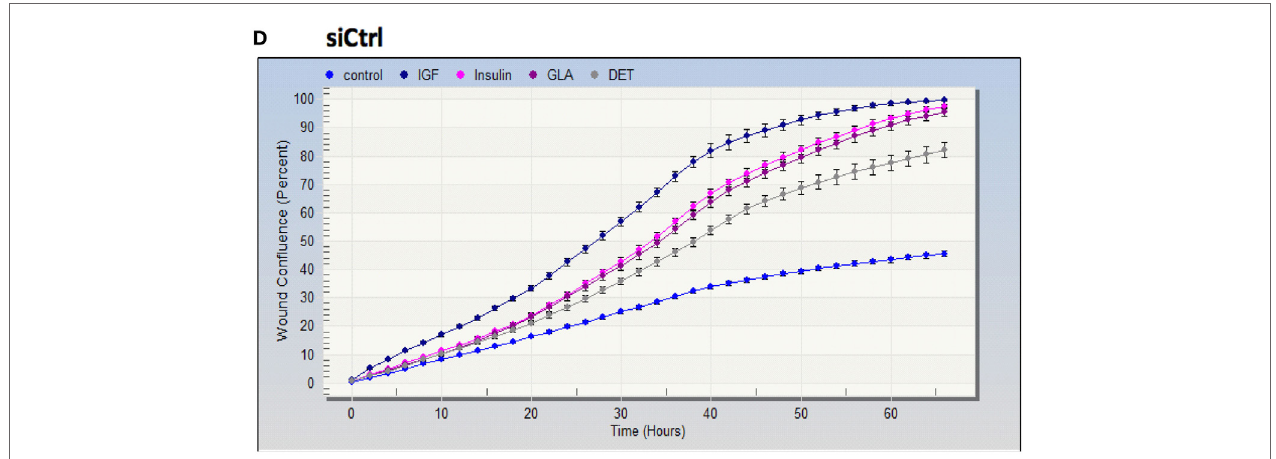
FigUre 13 | Cell migration measurement in FLNA-silenced cells. Cell migration assays were performed in ECC-1 cells transfected with 10 µM siFLNA (or siCtrl), as described in Section “Materials and Methods.” Cells were scratch wounded and monitored to determine the rate of migration into the scratched area. Representative images indicate areas of the scratch wound that are occupied by ECC-1 cells transfected with siFLNA (a) or siCtrl (b) , at 0 (initial scratch), 24, 48, and 60 h post-wounding. Results were plotted in terms of percentage wound confluence as a function of time (c,D) . Data are expressed as mean ± SD, n =